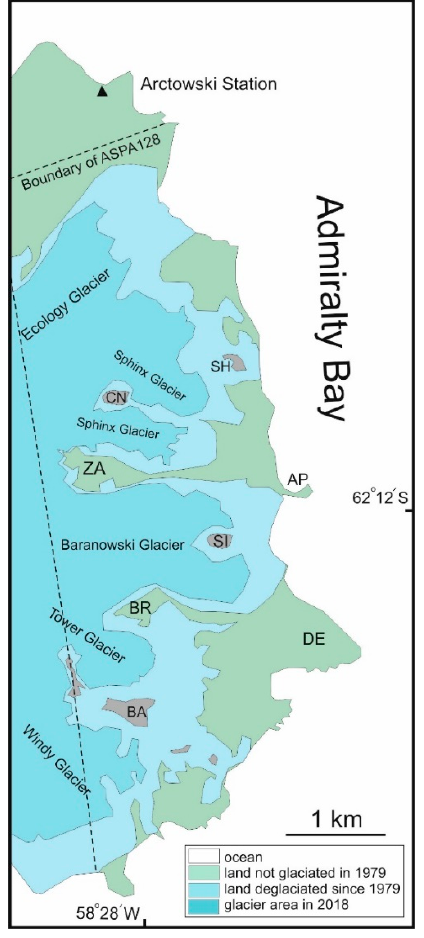
Figure 2. Location of main glaciers and topographic features on the west coast of Admiralty Bay (Antarctic Specially Protected Area No. 128) and Arctowski; contours of glaciers from Pudełko et al. [8]. SH—Sphinx Hill, CN—Czajkowski Needle, ZA—Zamek, AP—Agat Point, SI—Siodło, BR—Brama, DE—Demay Point, BA—Bastion.